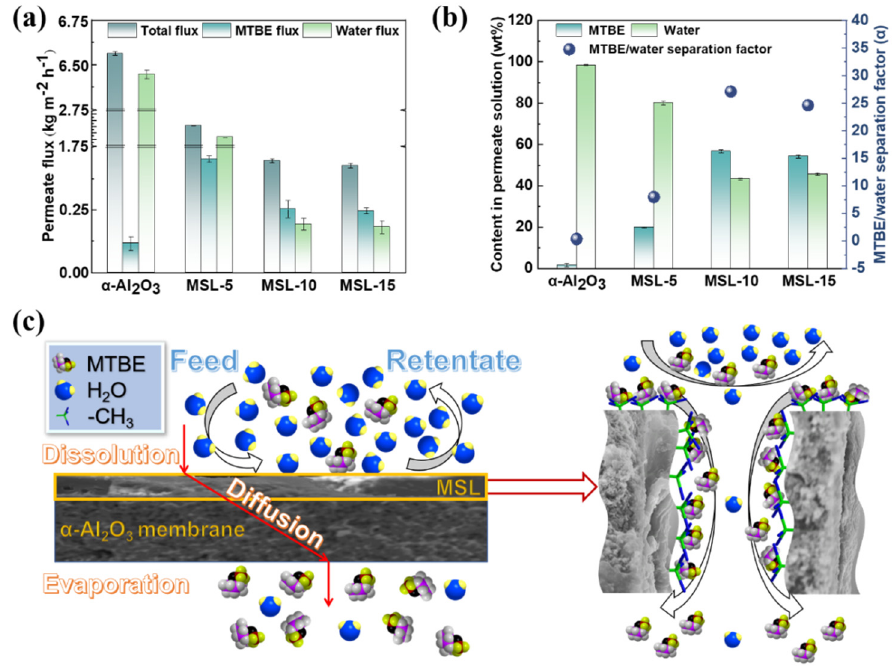
Figure 6. MTBE/water separation performance for the pristine and MSL deposited α -Al 2 O 3 mem- branes. Permeate flux ( a ); content in the permeate and separation factor ( b ). Proposed mechanism for the MTBE/water separation by MSL-deposited α -Al 2 O 3 ceramic membrane ( c